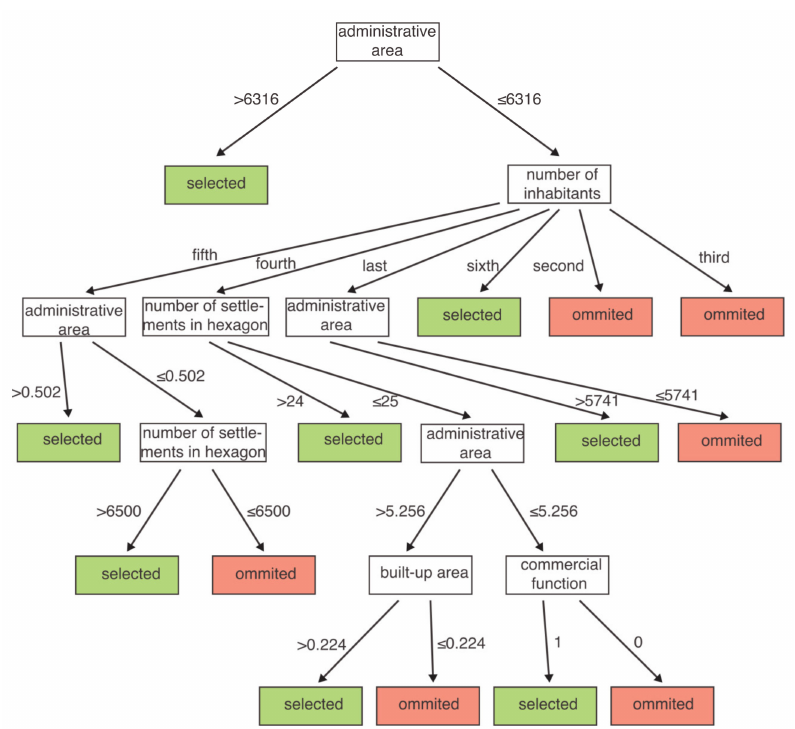
Figure 4. Decision tree for group 1, result of machine learning using decision trees with an optimized feature selection using a genetic algorithm (DT-GA)